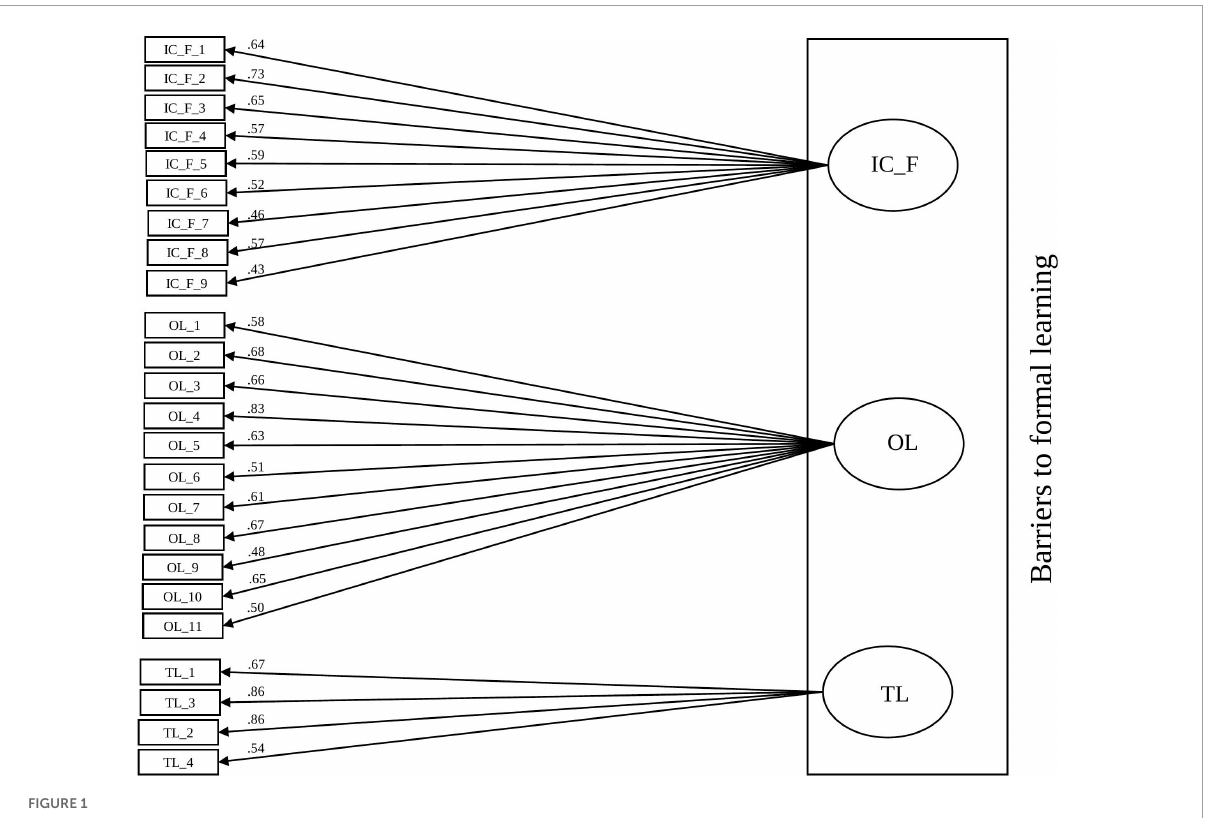
FIGURE1 Measurement model of barriers to formal learning.